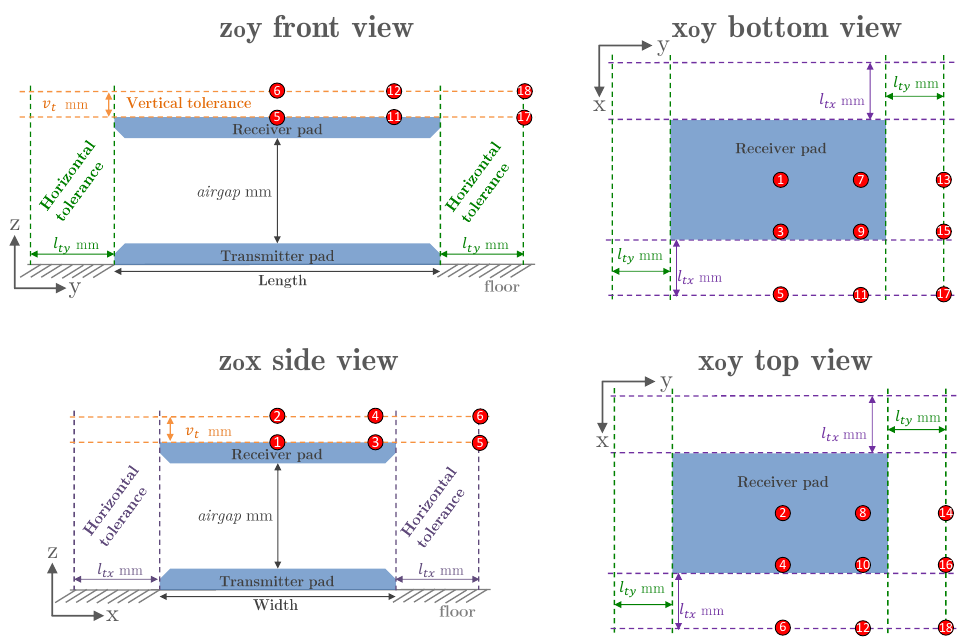
Figure 5. Operation area of the magnetic coupler. 1. Profile of L xy = f ( N x , N y ) : Figure 6 illustrates the surface of L xy = f ( N x , N y ) with a fixed value of airgap and l t , using the FEA results from Scenario A to Scenario D , identified by the alphabetic numbered green squares. Figure 6b depicts a 2D plane, view from the N x axis of Figure 6a. The value of L xy for specific values of N x and N y , exemplified by the red dot labeled as Point L xy in Figure 6b, can be identified by either linear functions L xy ( N x ) or L xy ( N y ) , illustrated by the red dashed lines, which intersect at the desired L xy value. The slope and intercept of L xy ( N x ) are determined using points P 1 and P 2 . The values of P 1 and P 2 are obtained using line